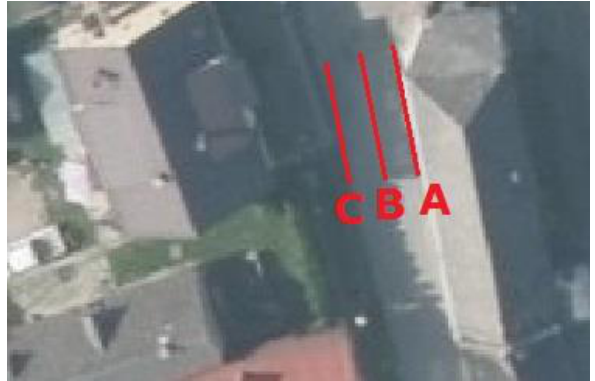
Figure 2. Measurement with GPR in sections A, B, C